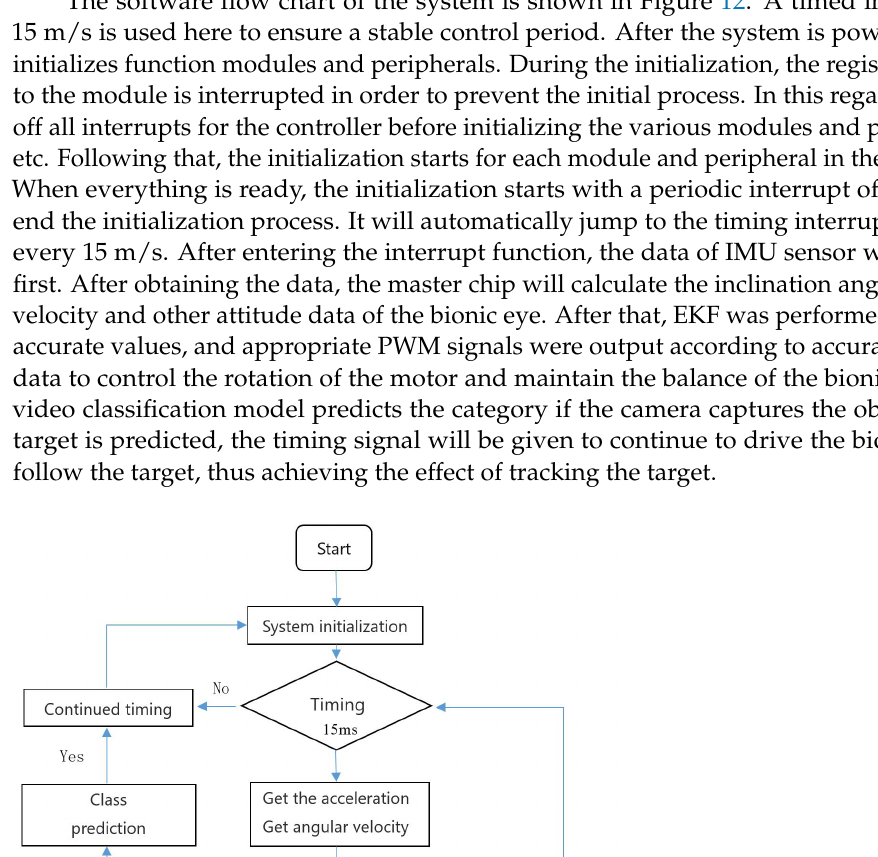
Figure 12. Software flow chart.